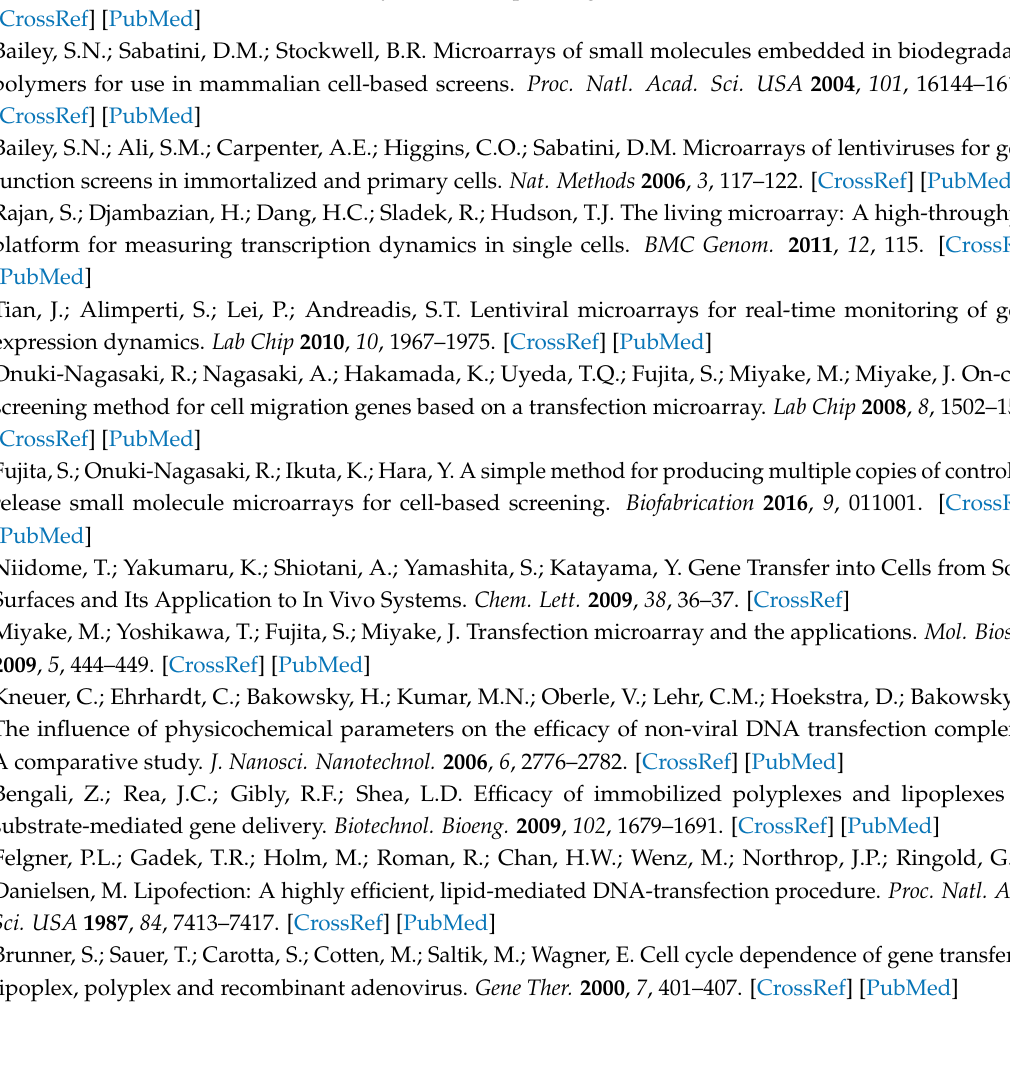
laps movie. Supplemental Figure S1. Overview of slide preparation and slide measurement. Figure S2. Printed DNA array before and after reverse transfection. Figure S3. Fluorescence image of a large reverse-transfected cell